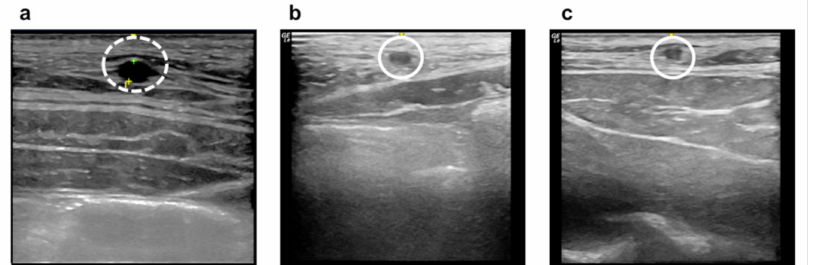
Figure 4. Ultrasound images of medical adhesive (EGpresto) injection sites: ( a ) normal epigastric vein before the procedure (dashed circle), ( b ) 7 d after injection, and ( c ) 14 d after injection (solid circles).